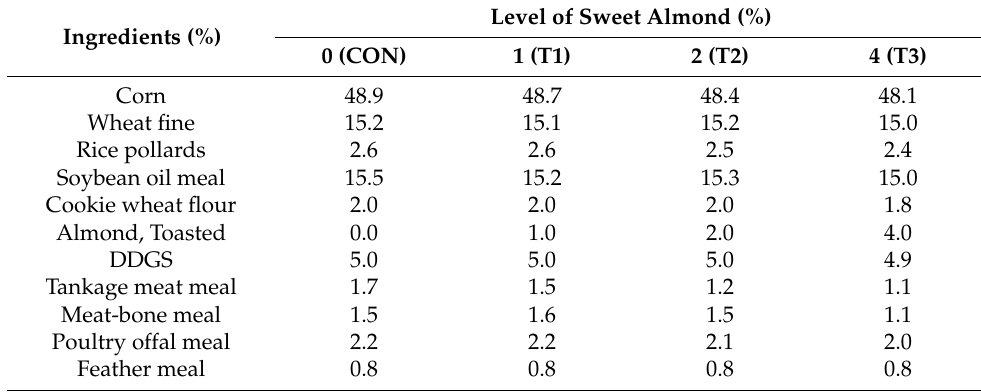
Table 5. Ingredient composition of experimental diets (phase 4/day